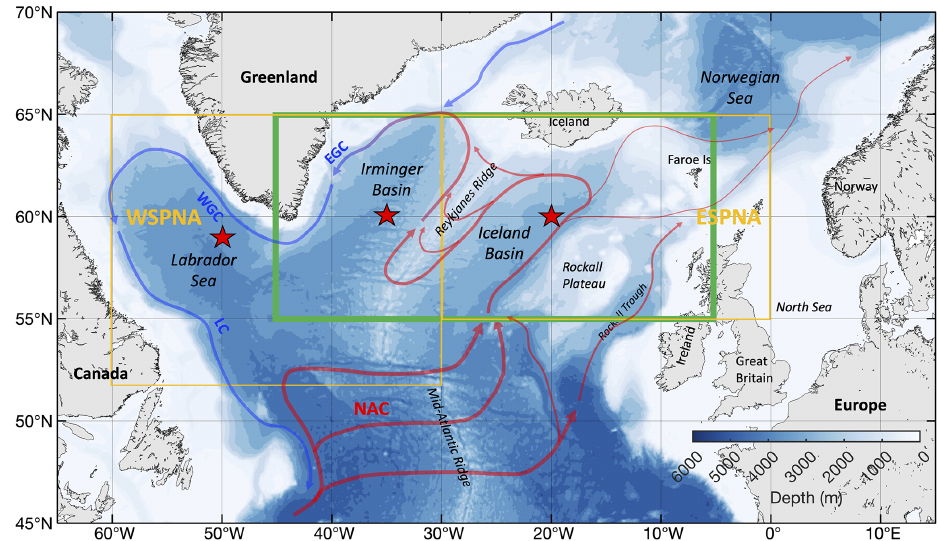
Figure 1. Bottom topography and schematic upper-ocean circulation in the subpolar North Atlantic. Abbreviations: NAC – North Atlantic Current, EGC – East Greenland Current, WGC – West Greenland Current, LC – Labrador Current. The green rectangle bounds the area used for averaging in Chafik et al. (2019). The orange rectangles bound the areas used for averaging in the western SPNA (WSPNA) and in the eastern SPNA (ESPNA). The red stars show the locations of temperature and salinity profiles shown in Fig.